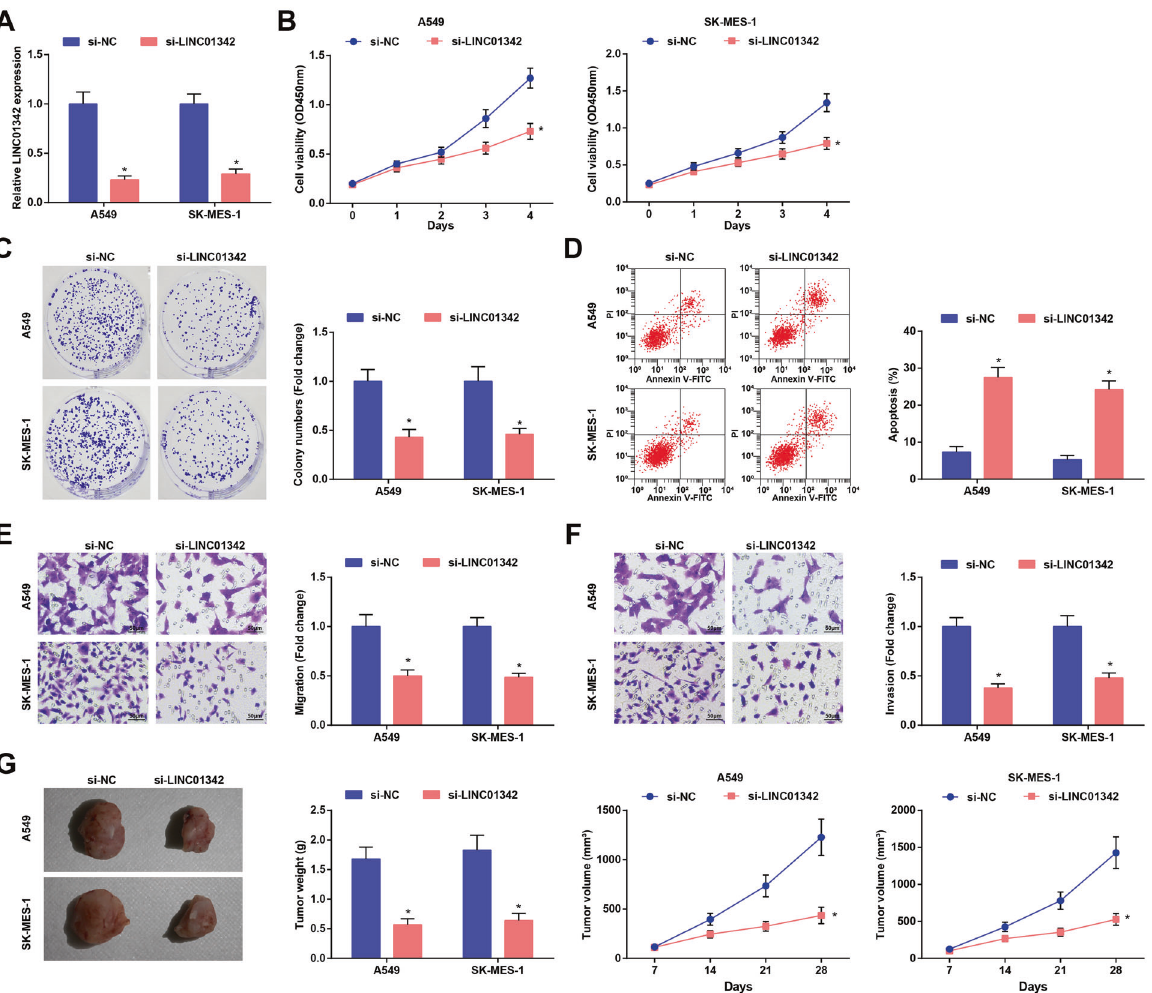
Fig. 2 LINC01342 silencing inhibits malignant behaviors of LC cells in vivo and in vitro. A LINC01342 expression in LC cells was determined using RT-qPCR. B Cell viability was assessed using CCK-8 assay. C Colony formation ability of cells was detected using cell colony formation assay. D Apoptosis of cells was assessed using fl ow cytometry. E and F Migration, and invasion of cells was detected using Transwell assay. G Representative image, volume and weight of xenografts from nude mice; * P < 0.05 vs. the si-NC